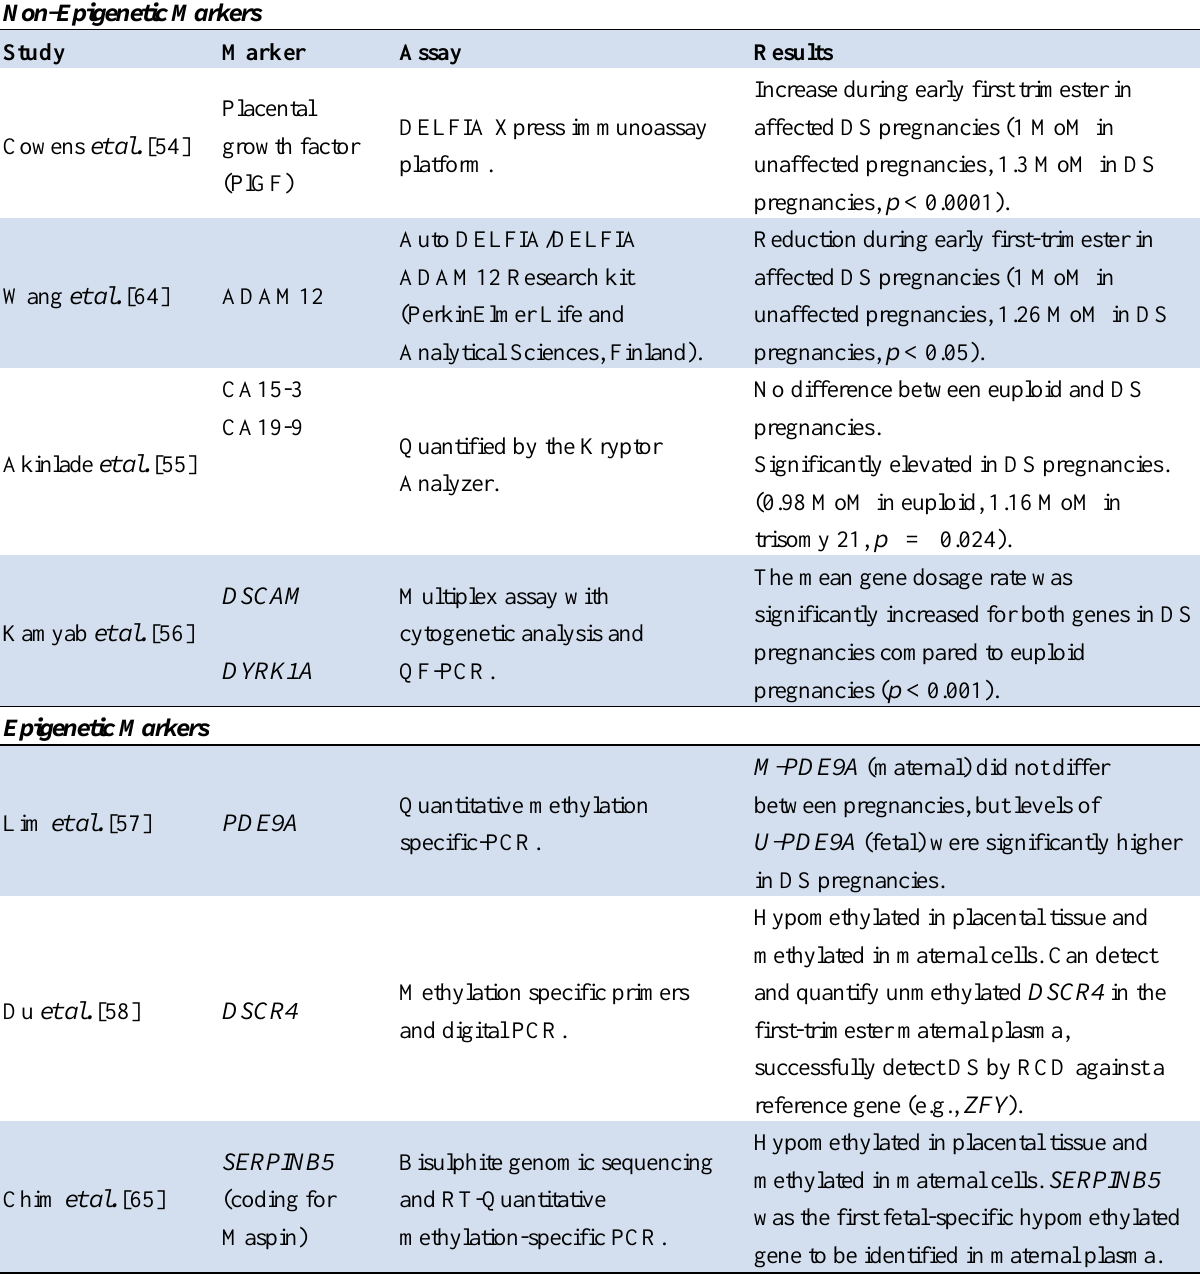
Table 1. Summary of studies identifying potential new biochemical markers for prenatal screening of